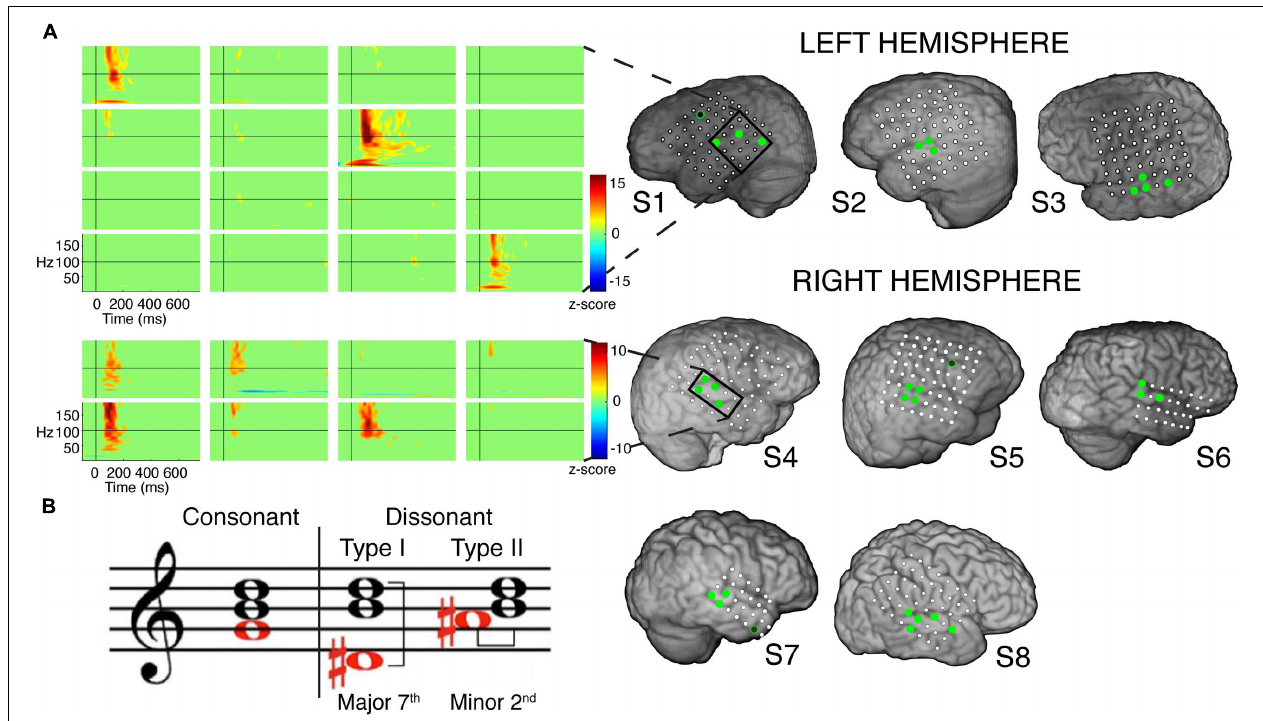
FIGURE 1 | (A) Electrode coverage of ECoG subjects; spatiotemporal responses to chord stimuli in subjects S1 and S4. Electrodes with significant activity ( p < 0.05 after FDR multiple comparison correction, ≥ 100 ms in duration) in response to chord stimuli are denoted in green. Non-STG electrodes with significant activity (1 each in subjects S1, S5, and S7) are denoted in black with a green border. Event-related spectral perturbations (ERSPs) are shown locked to stimulus onset for the boxed electrodes in subjects S1 (LH coverage) and S4 (RH coverage). Color scale represents statistically significant changes in power compared to a bootstrapped surrogate distribution. (B) Chord types used in the experimental design. From L to R: an example of a consonant chord, a dissonant type I chord containing a major seventh interval, and a dissonant type II chord containing a minor second